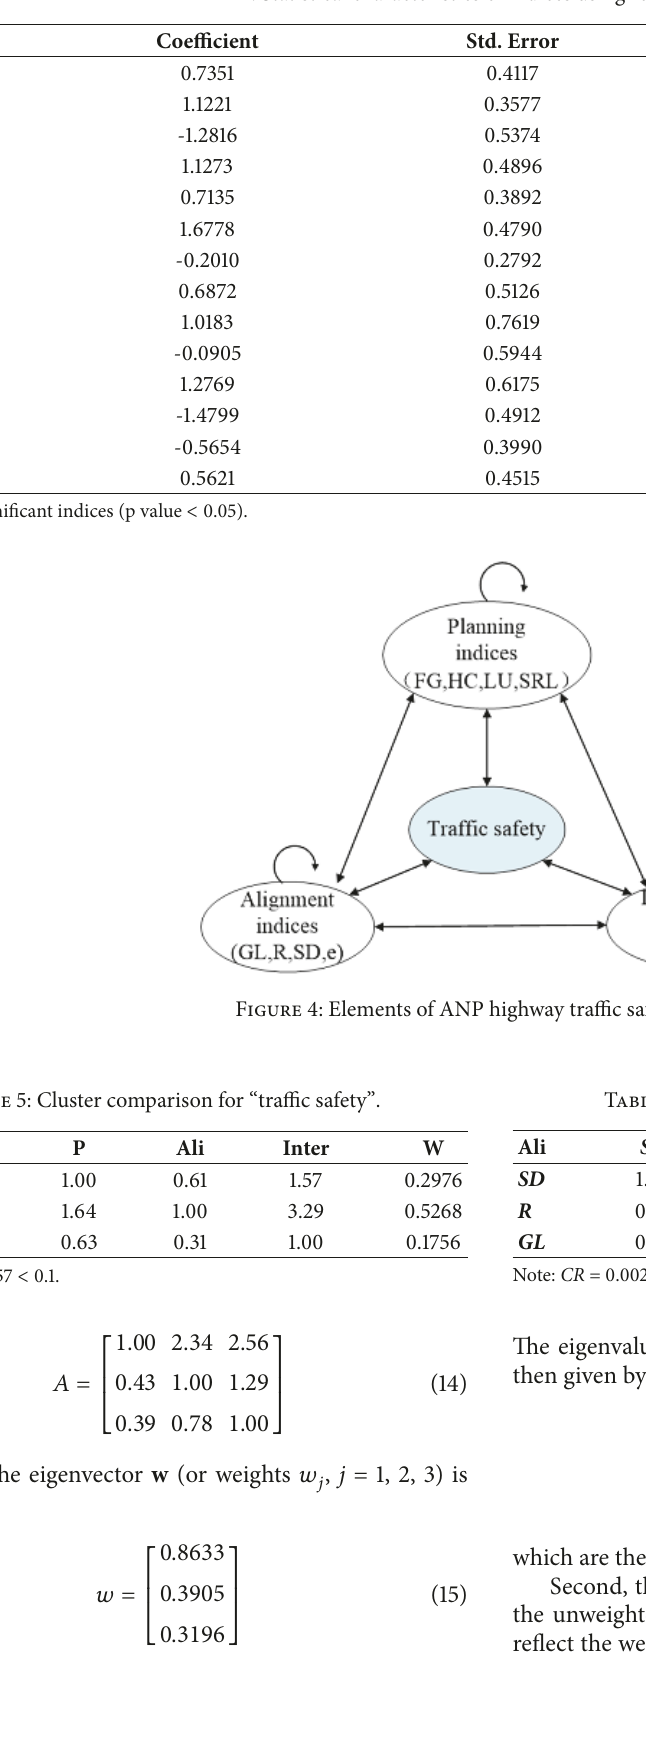
Table 4: Statistical characteristics of indices using regression analysis.